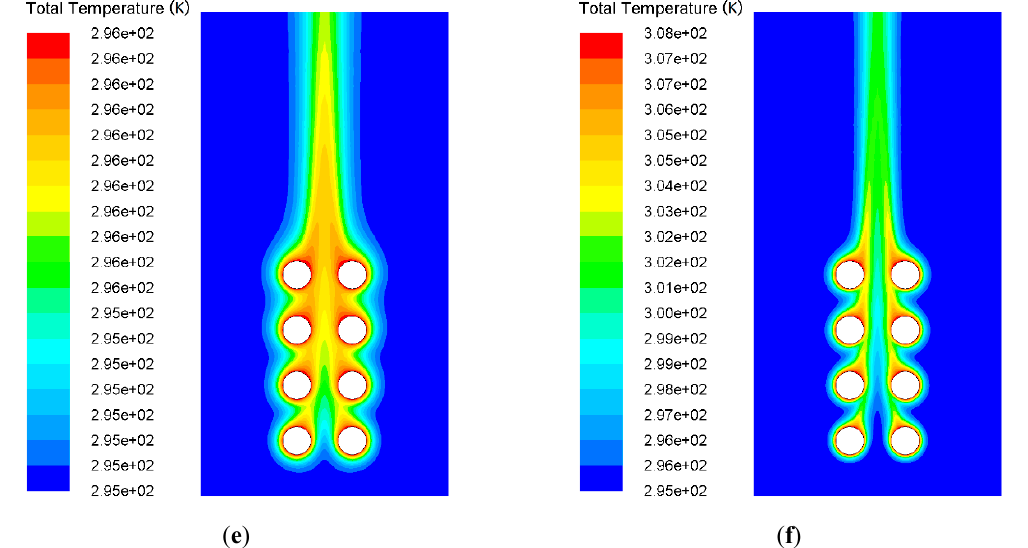
Figure 8. The temperature fields of the cylinder and tube arrays 4 × 1, 4 × 2: ( a ) single cylinder at Ra = 10 3 ; ( b ) single cylinder at Ra = 10 4 ; ( c ) tube array 4 × 1 at Ra = 10 3 ; ( d ) tube array 4 × 1 at Ra = 10 4 ; ( e ) tube array 4 × 2 at Ra = 10 3 ; ( f ) tube array 4 × 2 at Ra = 10 4 .